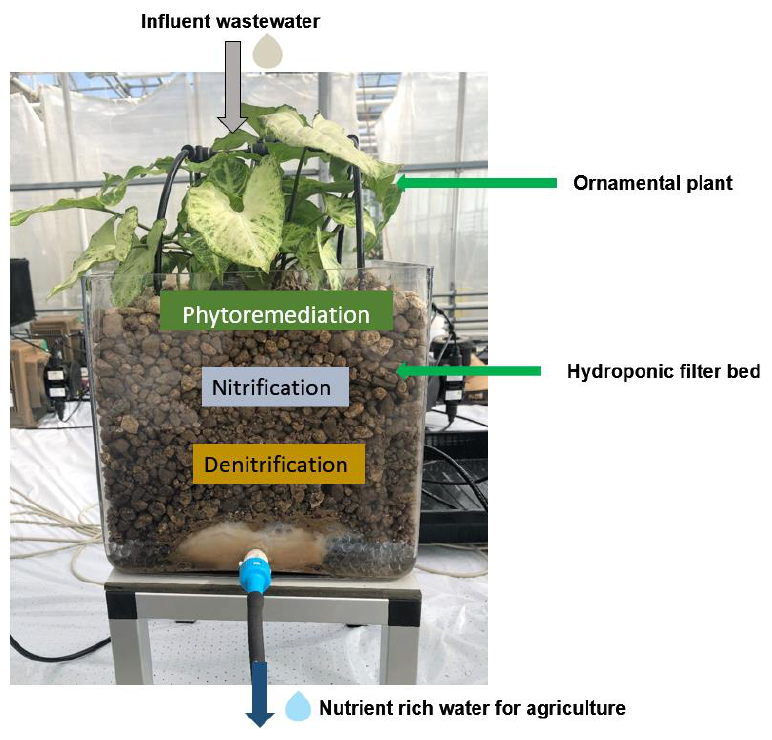
Figure 2. Mesocosm